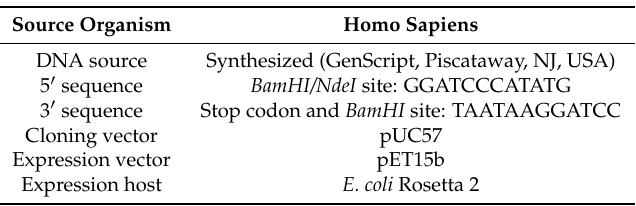
Table 2. Enzyme Table 2. Enzyme production.